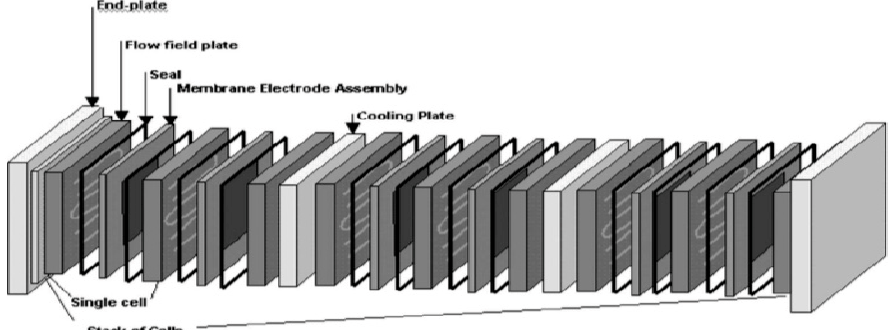
Figure 2. Removable fuel cell stack (Source: Mehta and Cooper (2004) [35]).